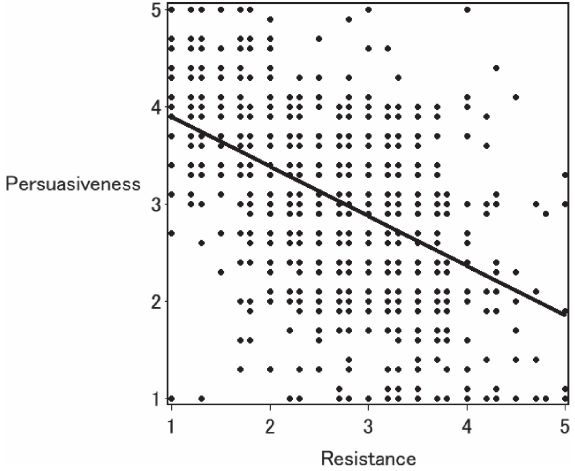
Fig. 2 Scatter plot between the reactance score and persuasive- ness score Regression line: Reactance score = % 0.511 ' Persuasiveness score +